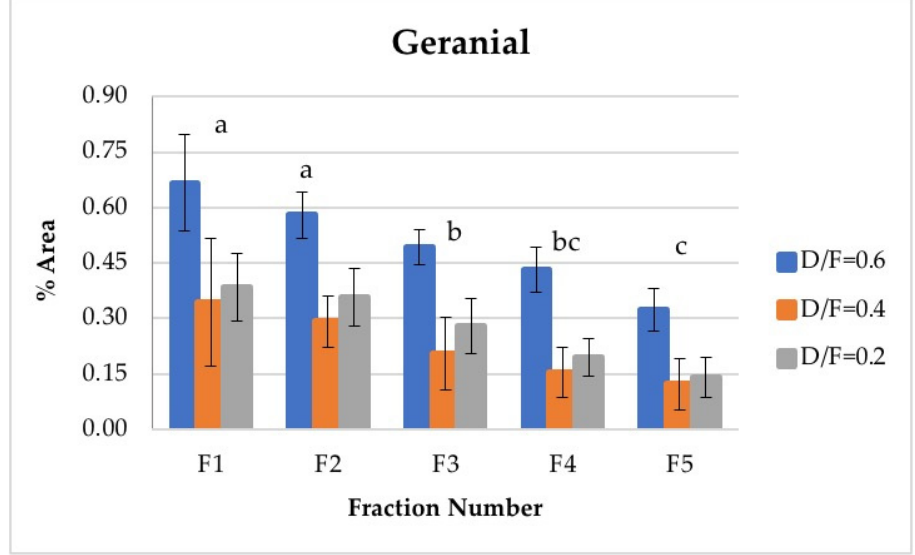
Figure 13. Abundance profile vs. number fraction for geranial. The results are the average of three replicates ± standard deviation. Different letters over a column indicate statistical differences (Tukey, p < 0.05).